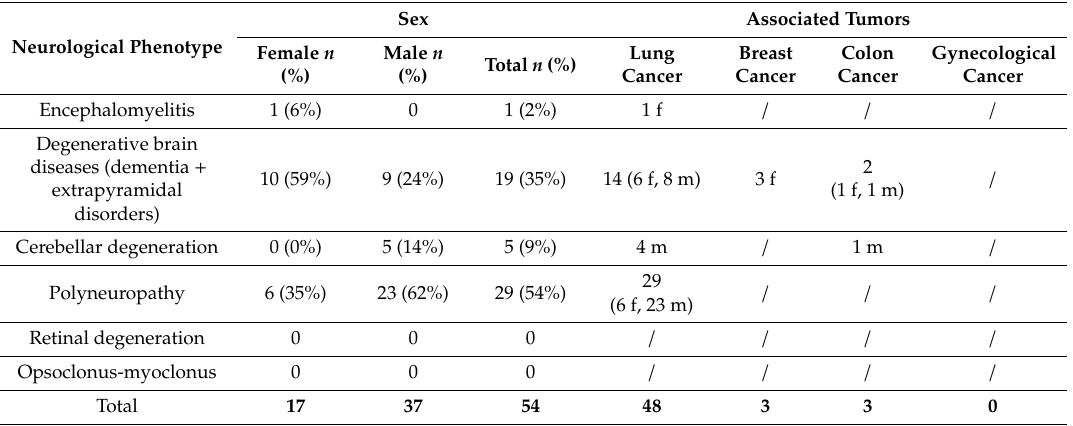
Table 2. Distribution of PNS patients in hospitals in the province of Brescia from 1998 to 2003. f = female, m =